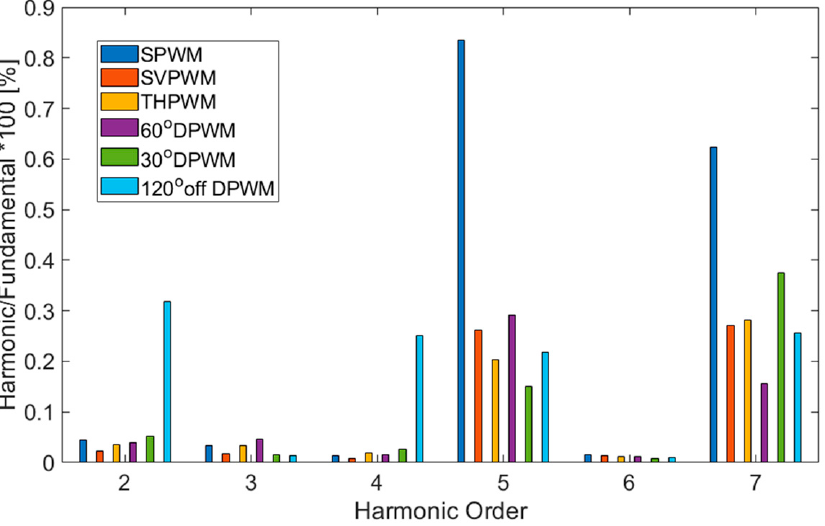
Figure 13. Simulation results of phase current harmonics in steady state at 1500 rpm and 1.0 Nm.